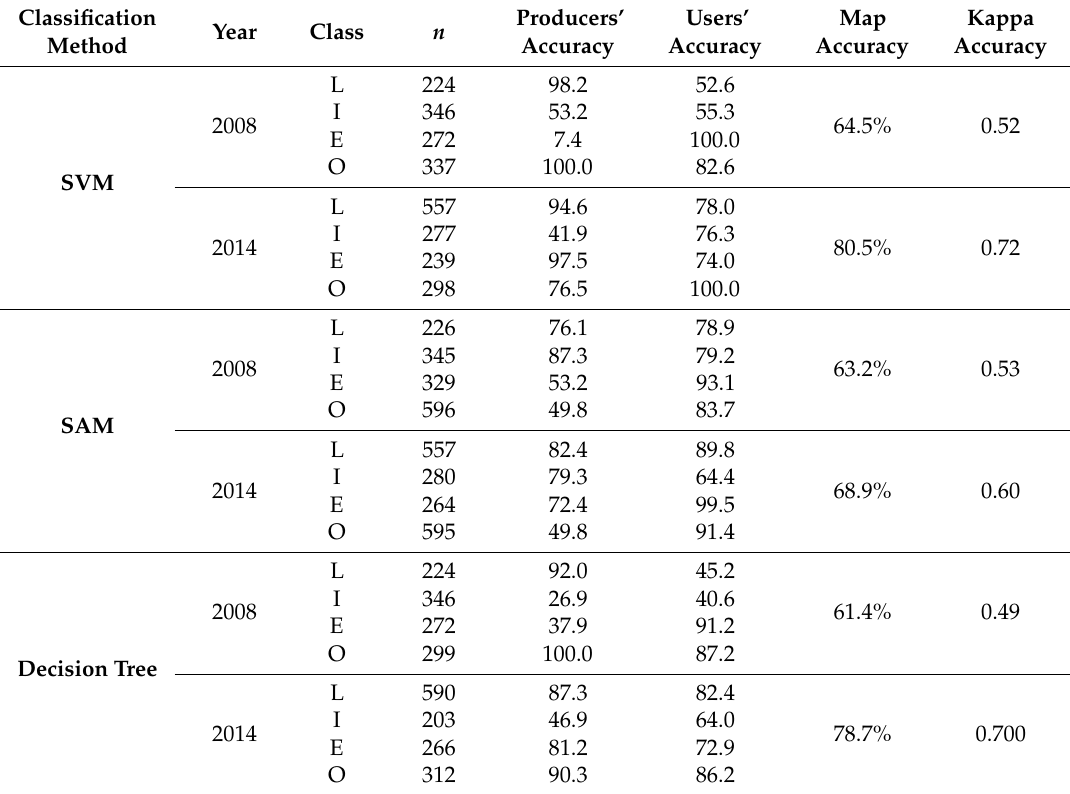
Table 5. Accuracy assessment of maps of successional stages in PEMS, for 2008 and 2014.